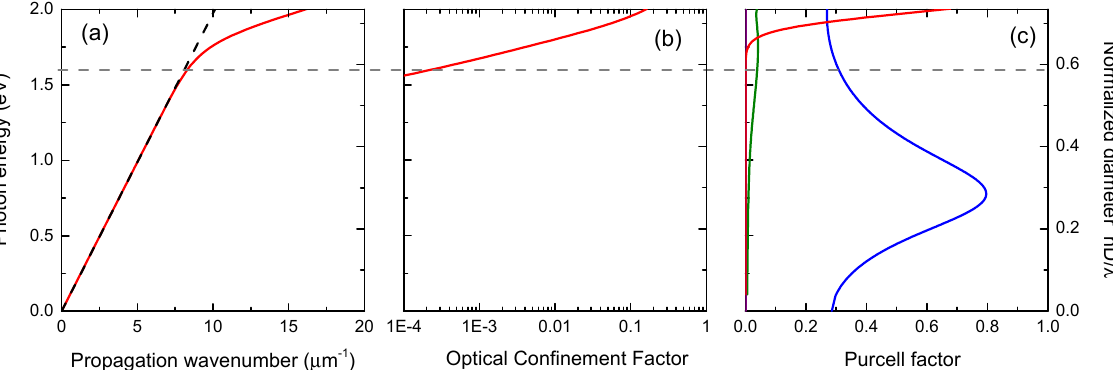
Figure 3. ( a ) Dispersion for HE11 mode in NW; ( b ) optical confinement factor g for HE 11 mode; ( c ) Purcell factor for dipole on the axis interacting with NW for HE 11 mode (red line), leaky modes interacting with radial dipole (green line) and axial dipole interacting with TM 0 leaky modes (blue line).